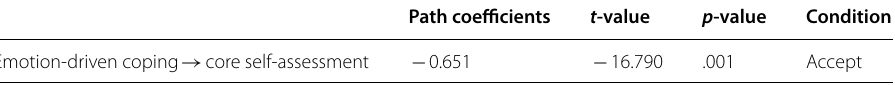
Significant at the level of 0.01 ( p <